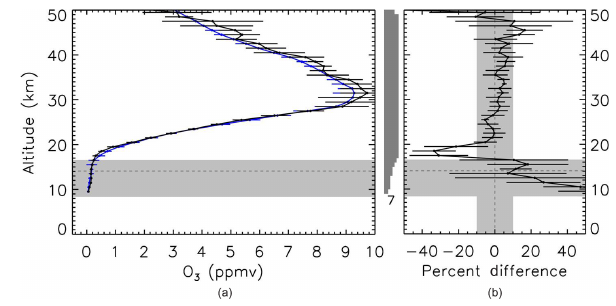
Figure 11. Similar to Fig. 2 but for the average difference between SAGE III-ISS lunar occultation measurements and the ACE-FTS ozone. Seven comparisons between the SAGE III-ISS lunar and ACE-FTS measurements are